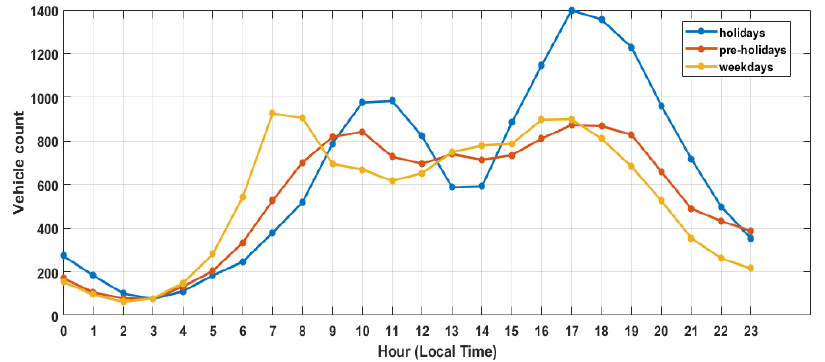
Figure 4. San Demetrio gallery: daily vehicular flow as hourly average over the three months April–June, differentiating among weekdays (orange), pre-holidays (red) and holidays